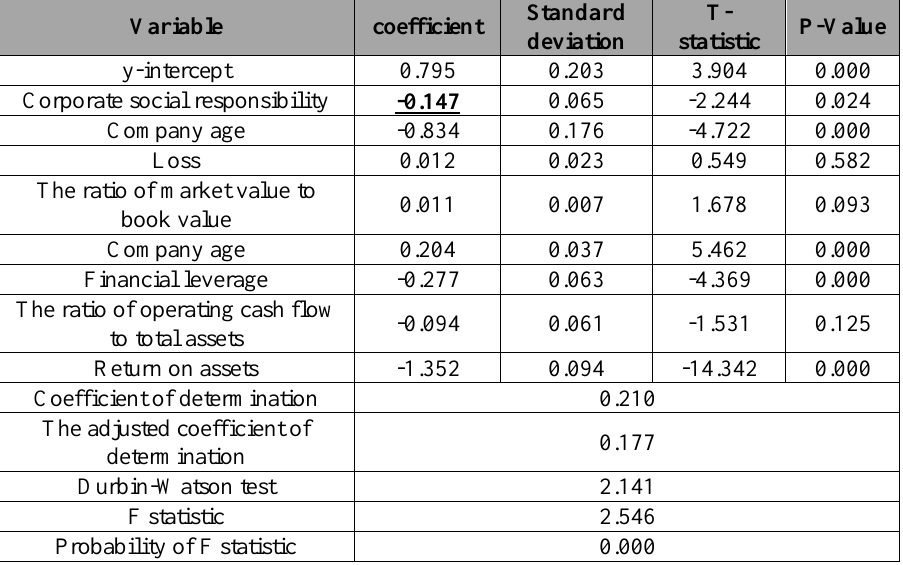
Table 9. Estimation results of the first research